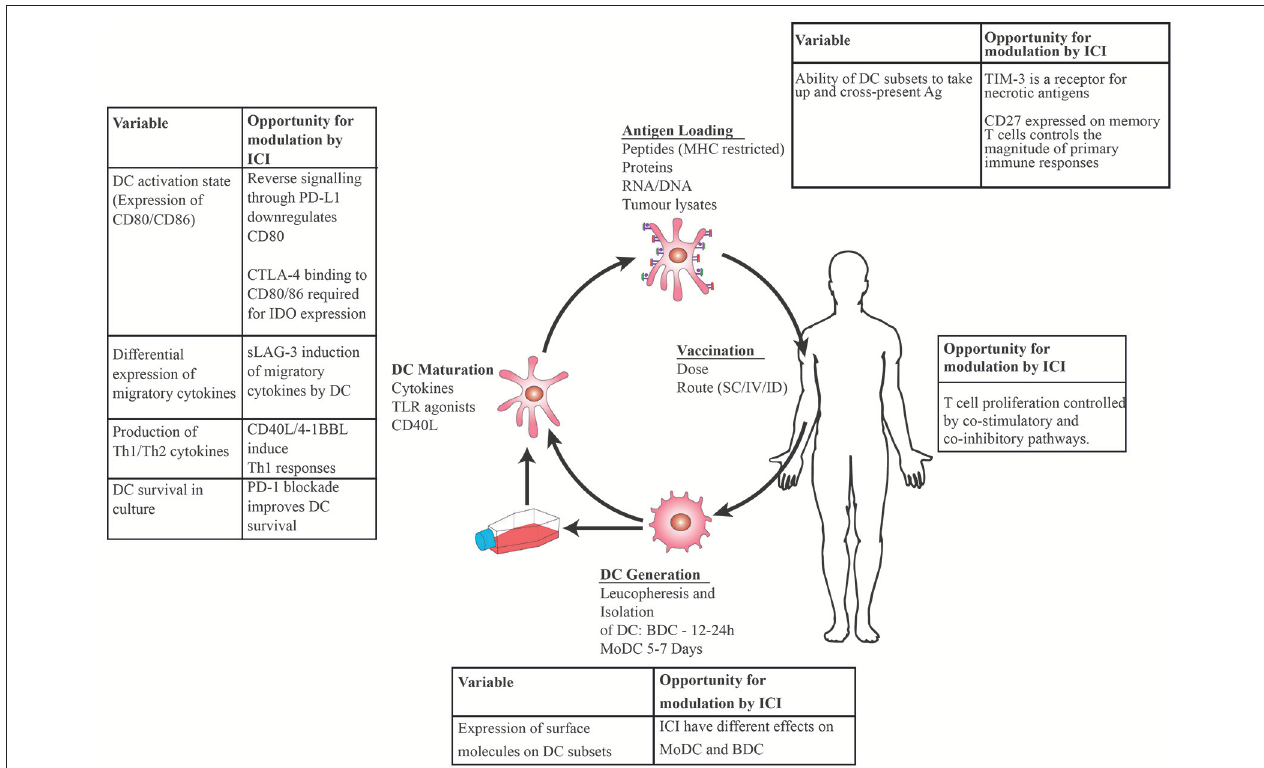
FIGURE 1 | Schematic showing DC vaccination: DC are generated by leucopheresis and isolation by immunoselection, matured ex vivo using cytokines then loaded with tumor antigens prior to injection back into the patient. Immune checkpoint inhibitors (ICI) administered at the time of DC maturation and antigen loading will have direct effects on DC in addition to modulating T cell: tumor interactions, leading to opportunities to modulate immune responses at the level of DC, T cell